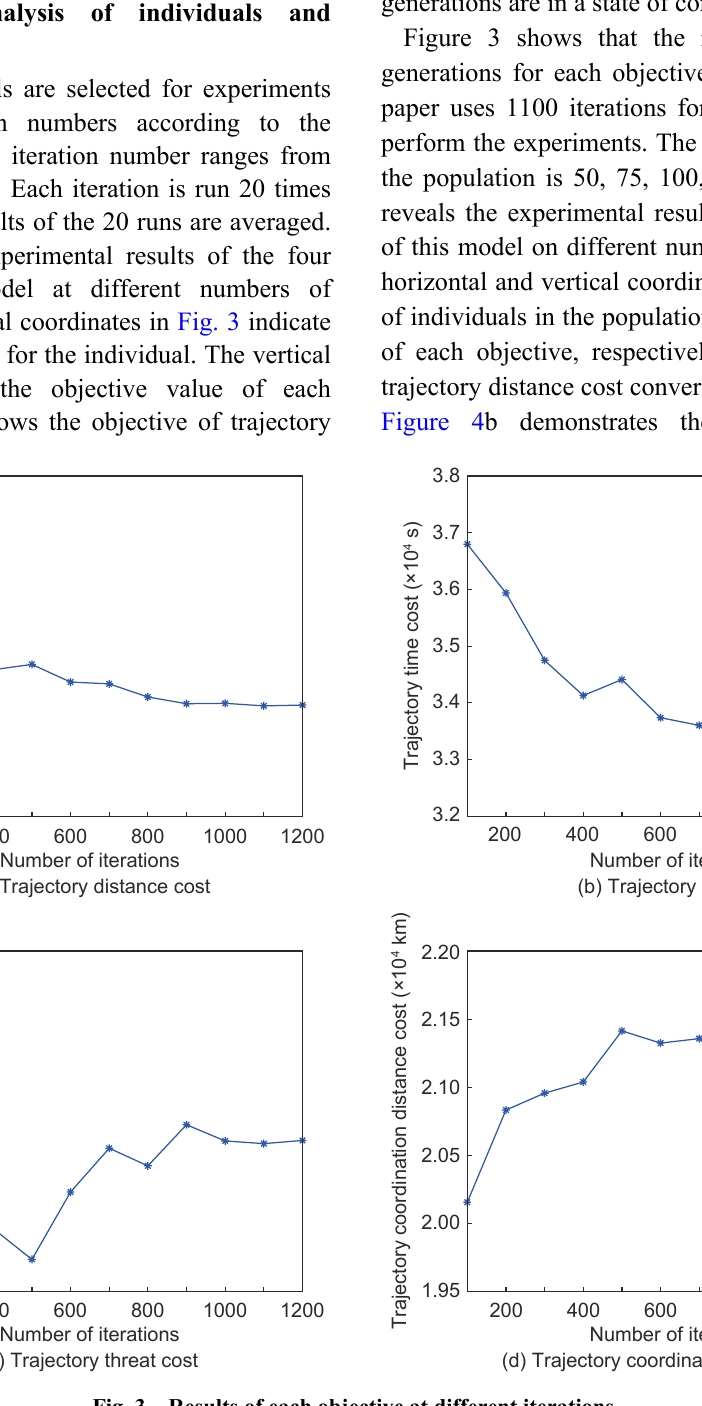
Fig. 3 Results of each objective at different